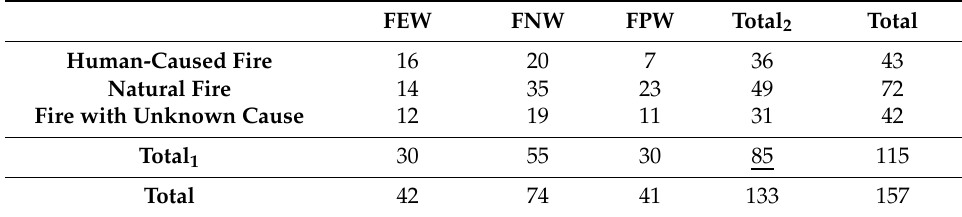
Table 2. Fire data counts used in this